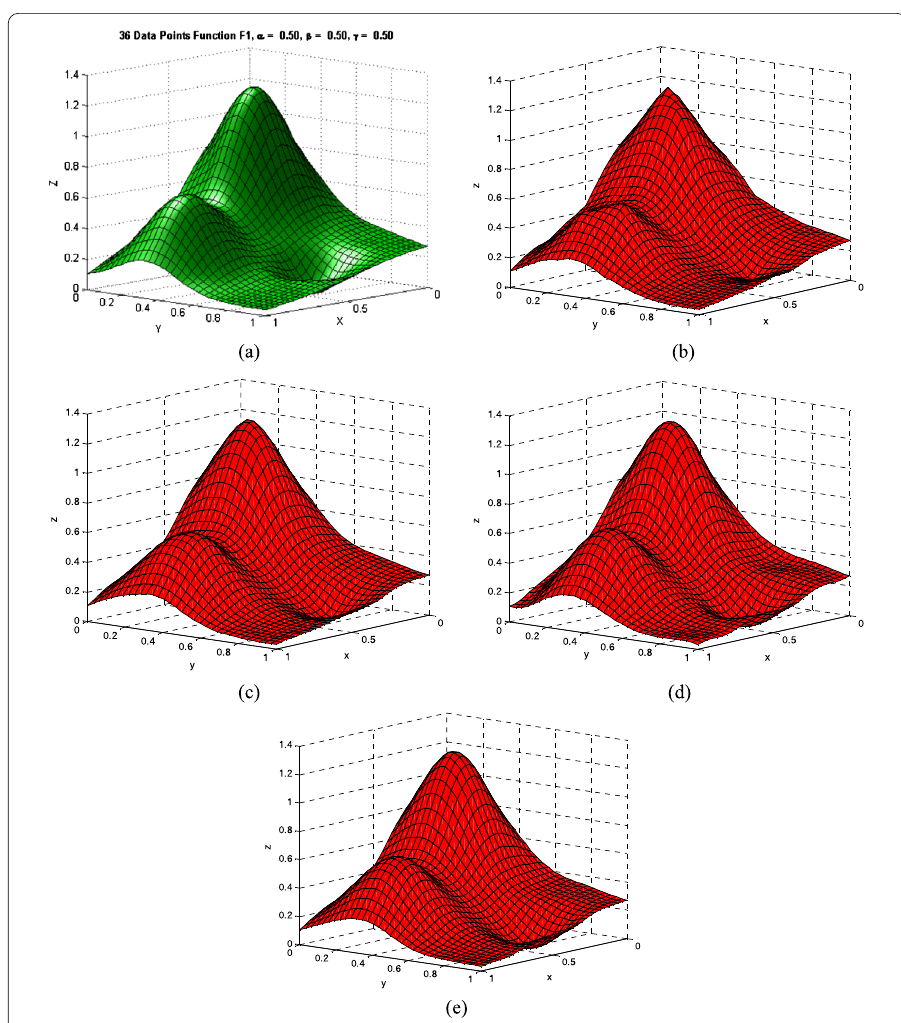
Figure 8 Surface interpolation for 36 data points for the test function F 1 : ( a ) The proposed method; ( b ) RBF (linear); ( c ) RBF (thin plate spline); ( d ) RBF (Gaussian); ( e ) RBF